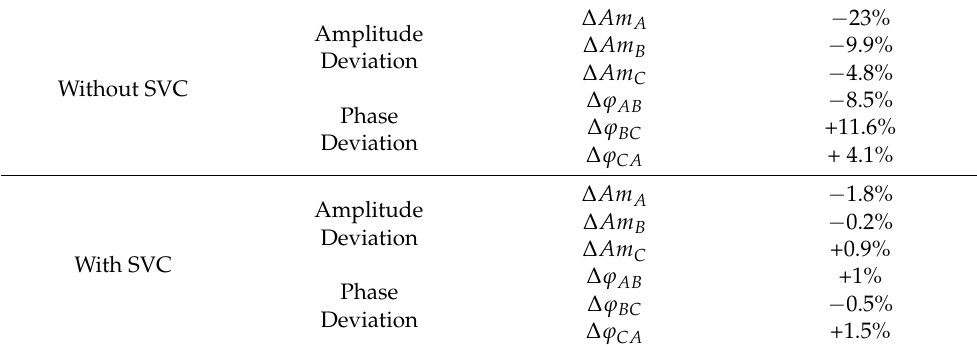
Table 3. Maximum deviations in amplitude and phase of